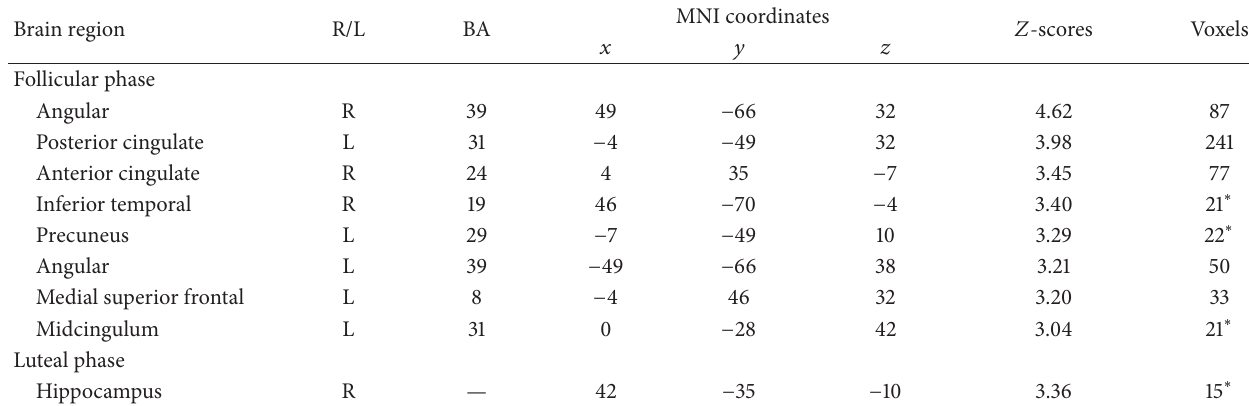
Table 2: Cerebral activations of female participants, during viewing of appetitive cigarette images (relative to neutral images) and during the follicular and luteal menstrual cycle phases. R = right; L = left; BA = Brodmann area; 𝑃 value is uncorrected at 0.001. Brain